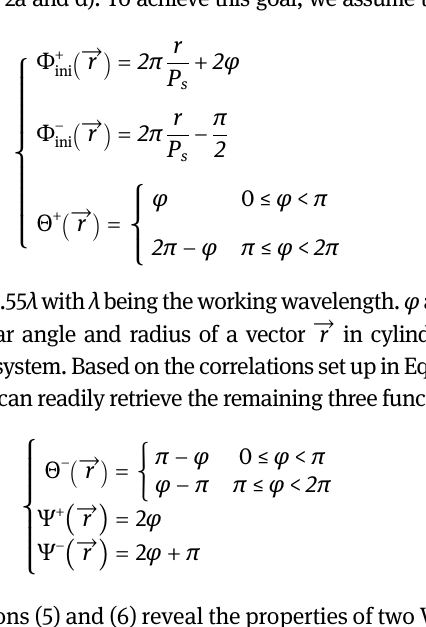
→ → → ( r ) , Θ σ ( r ) , Ψ σ ( r )} distributions as given by Eqs. (5) and (6), under ini